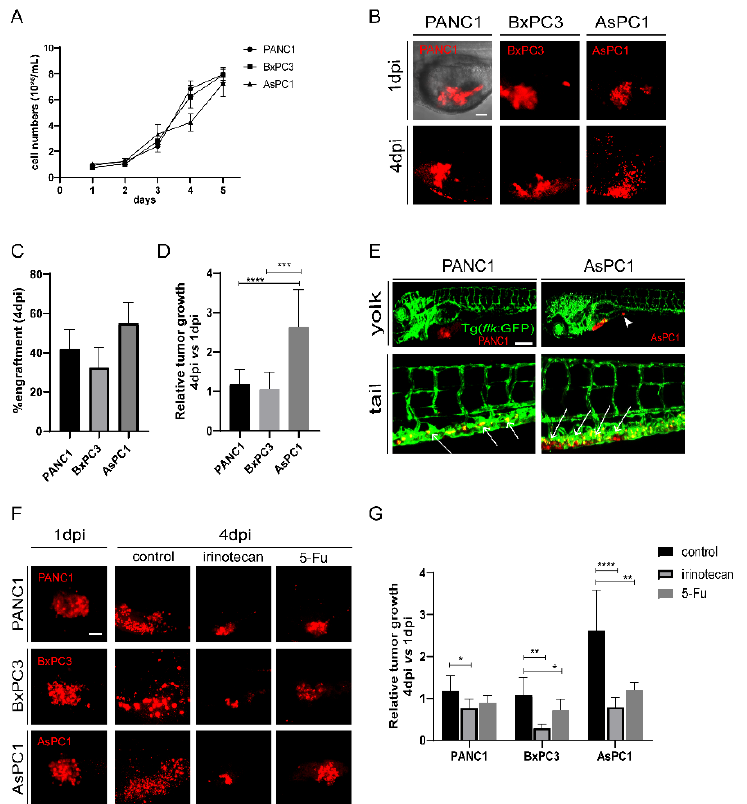
Figure 1. The pancreatic cancer cells show differential engraftment profile in zebrafish. ( A ) The growth curve of in-vitro cultured PANC1, BxPC3, and AsPC1 cells. ( B ) Representative confocal images of PANC1, BxPC1, and AsPC1 xenografts at 1 dpi and 4 dpi. ( C ) Engraftment quantification for PANC1, BxPC1, and AsPC1 cells at 4 dpi. Results are shown as means ± SEM from 50 different individuals. ( D ) Relative tumor growth (4 dpi vs. 1 dpi) for PANC1, BxPC3, and AsPC1 xenografts. Results are from nine different individuals (*** p < 0.001, **** p < 0.0001, t test). ( E ) PANC1 and AsPC1 showed metastasis in the intestine (white arrowheads) and in the caudal hematopoietic tissue (white arrows). ( F ) Representative confocal images of PANC1, BxPC3, and AsPC1 xenografts at 1 dpi or at 4 dpi after DMSO (control), irinotecan (50 µ M) or 5-Fu (2 mM) treatment. ( G ) Relative tumor growth (4 dpi vs. 1 dpi) for PANC1, BxPC3, and AsPC1 xenografts after treatment with DMSO, irinotecan or 5-Fu. Results are from nine different individuals (* p < 0.05, ** p < 0.01, *** p < 0.001, **** p < 0.0001, t test). dpi, days post injection. Scale bars in ( B , F ), 50 µm; in ( E ), 75 µm.